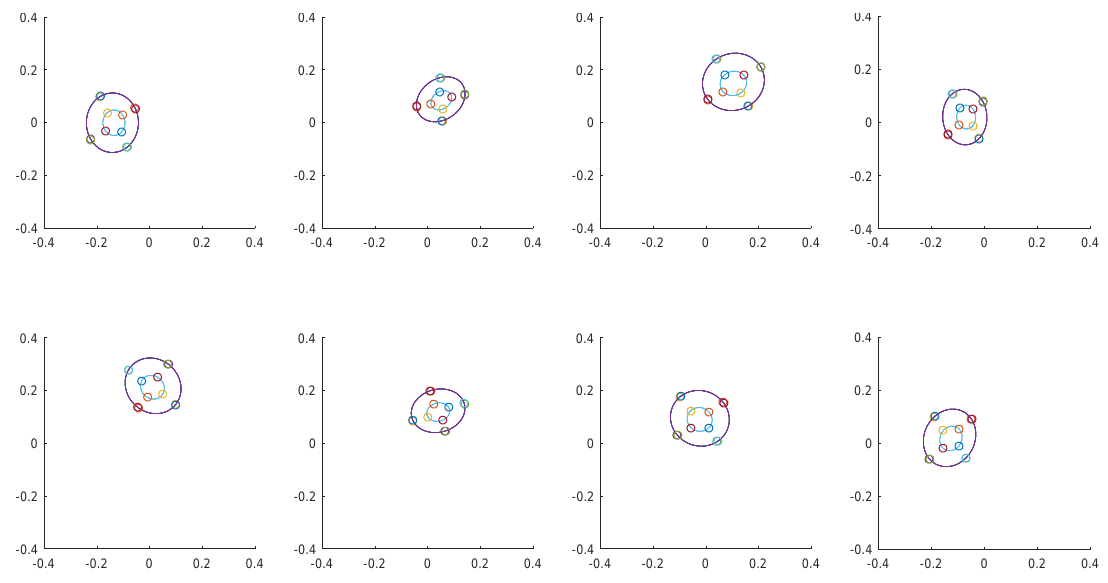
Figure 12. Marker trajectories in the eight Vicon camera unit planes—circles on ellipses indicate locations of main outliers of the Figure 9—A color represents the same marker seen from different cameras. Marker B trajectory corresponds to the small ellipse. Marker A trajectory corresponds to the large